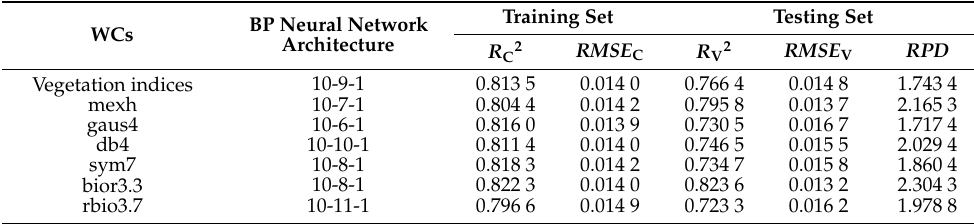
Figure 7. RMSE variation of the testing set with different numbers of hidden layer nodes. Table 7. Fv/Fm estimation model based on CWT and BPNN.